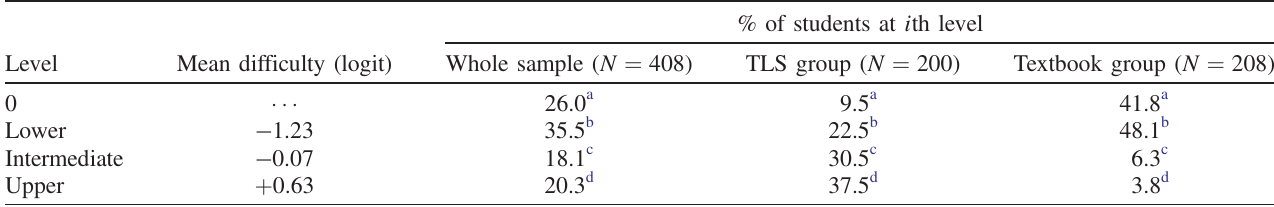
TABLE VI. Distribution of TLS and textbook group students across the levels of the revised HCM (Table IV).